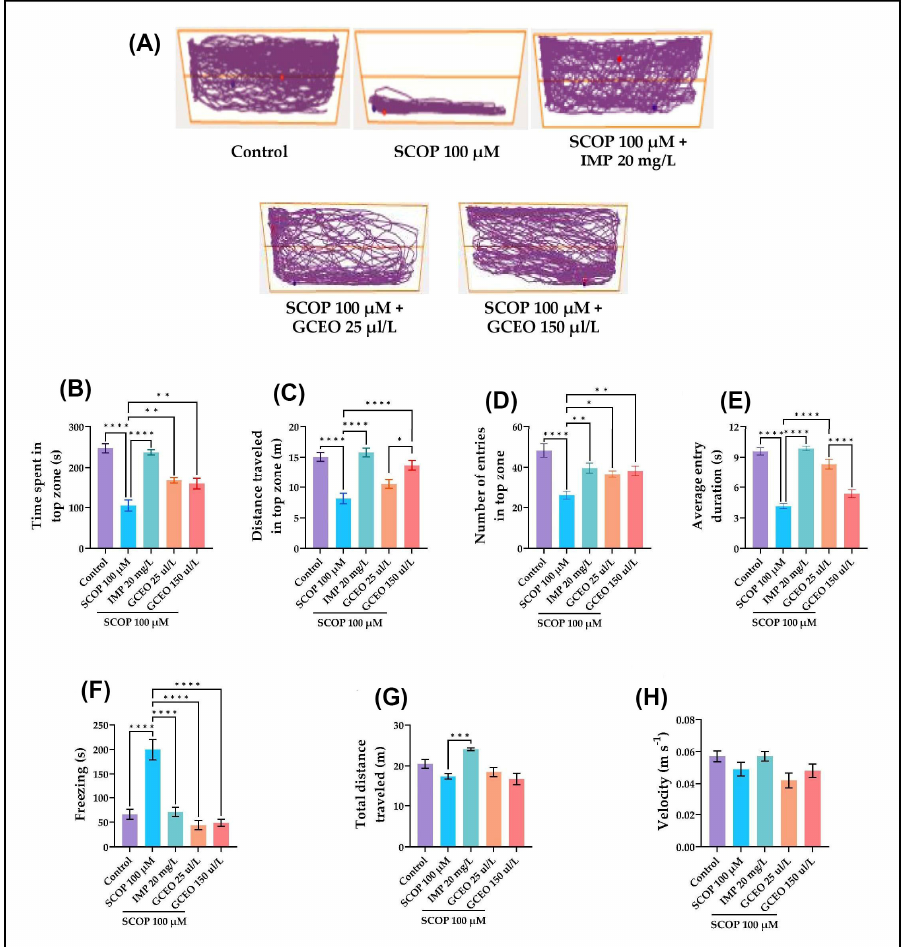
Figure 2. NTT results for Glaucosciadium cordifolium essential oil (GCEO, 25 and 150 µL/L). ( A ) The representative locomotion tracking patterns of the zebrafish in the NTT task. ( B ) Time spent in top zone (s). ( C ) Distance traveled in top zone (m). ( D ) Number of entries in top zone. ( E ) Average entry duration (s). ( F ) Freezing (s). ( G ) Total distance traveled (m). ( H ) Velocity (m −1 s). Data are expressed as mean ± S.E.M. ( n = 10). One-way ANOVA revealed overall significant differences between groups in ( B ) F(4,45) = 31.33, p < 0.0001, ( C ) F(4,45) = 18.38, p < 0.0001, ( D ) F(4,45) = 10.64, p < 0.0001, ( E ) F(4,45) = 52,94, p < 0.0001, ( F ) F(4,45) = 28.01, p < 0.0001 and ( G ) F(4,45) = 8.924, p < 0.0001. For Tukey’s post hoc analyses, **** p < 0.0001, *** p < 0.001, ** p < 0.01 and * p < 0.05.